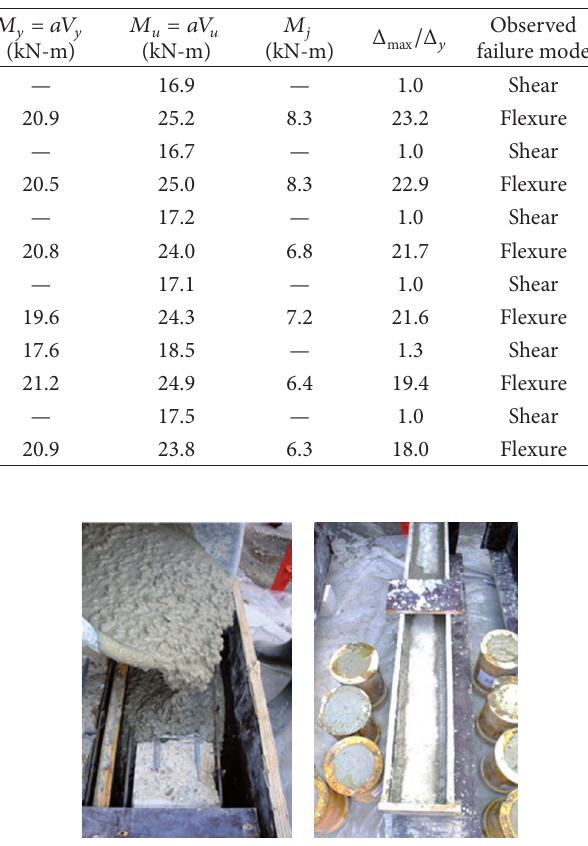
T 6: Experimental results.